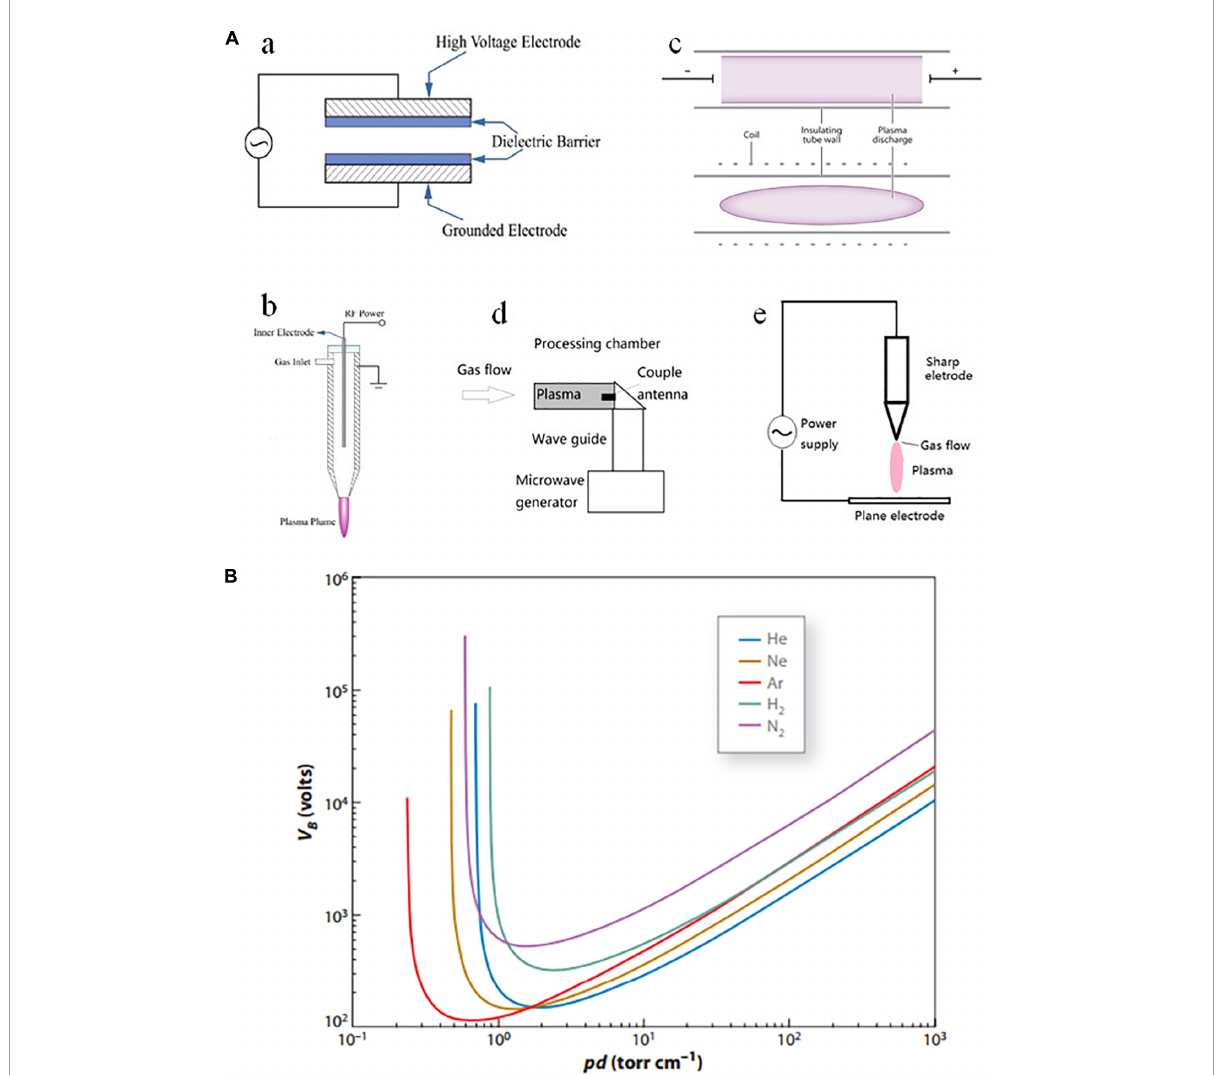
FIGURE1 (A) Schematic diagram of different plasma sources: (a) dielectric barrier discharge, (b) plasma jet, (c) radio frequency discharge, (d) microwave discharge, and (e) corona discharge plasma jet (25, 35, 36). (B) Paschen ionization curves obtained for helium (He), neon (Ne), argon (Ar), hydrogen (H2), and nitrogen (N2). VB (breakdown voltage, in volts) as a function of pd (pressure × distance, in torr cm − 1 ) under parallel plate electrodes